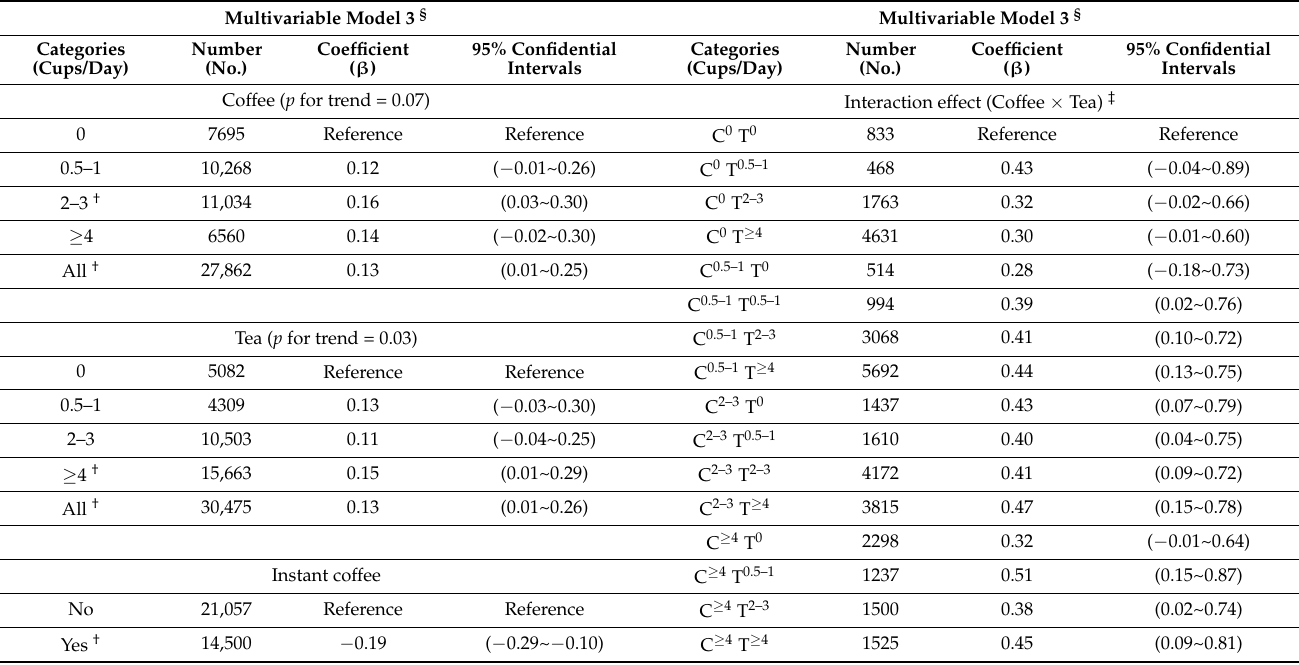
Table 3. Association between coffee and tea consumption with the average thickness of macular retinal fiber never layer in multivariable linear regression models after further adjusting for the habitual intake of instant